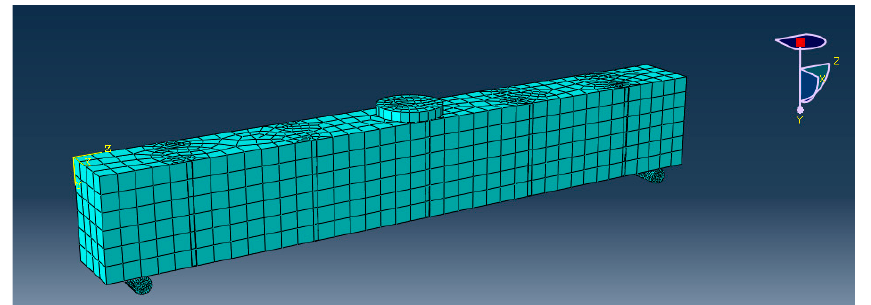
Figure 8. Meshing. Figure 8.